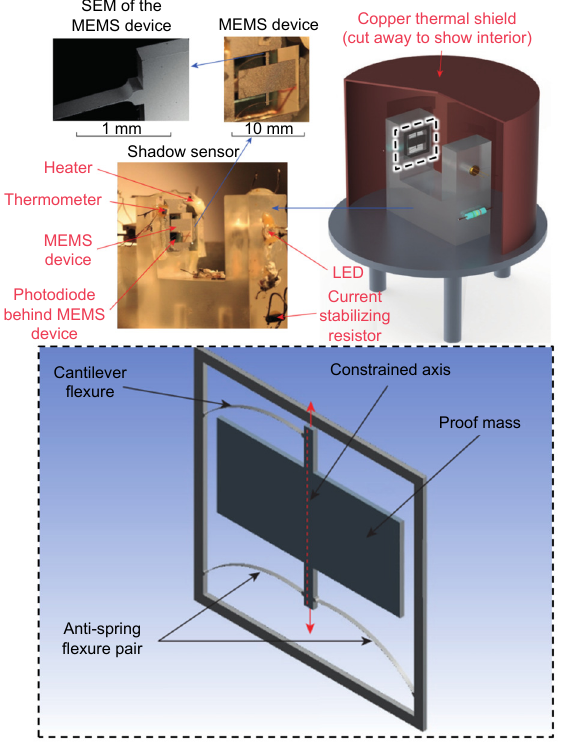
Fig. 6 | The experimental setup along with the mechanics. Fig- ure reproduced with permission from ref. 23 , Springer Nature.